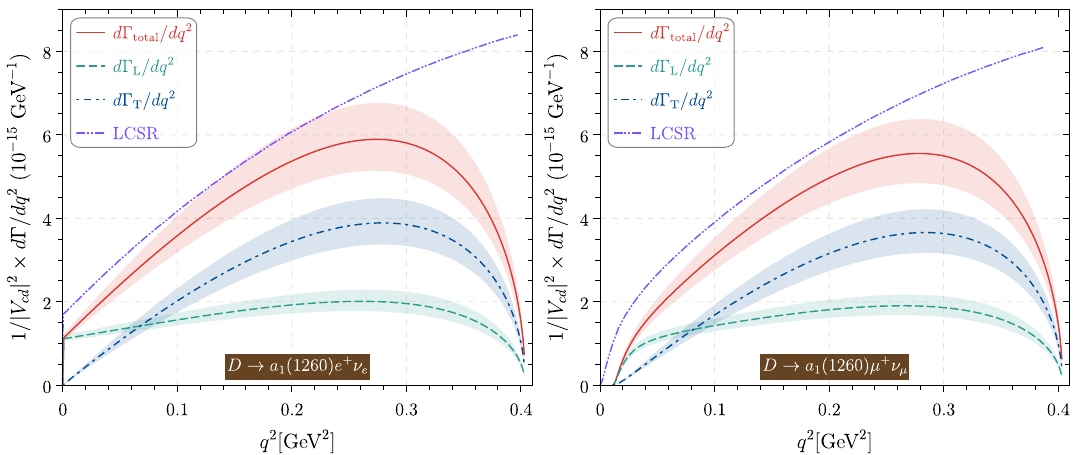
Fig. 4 The D → a 1 ( 1260 )(cid:4) + ν (cid:4) decay width with q 2 by using the chiral LCSR for the TFFs, where the upper and lower ones are for (cid:4) = ( e ,μ) , respectively. As a comparison, we also present the other LCSR results from Ref. [66]